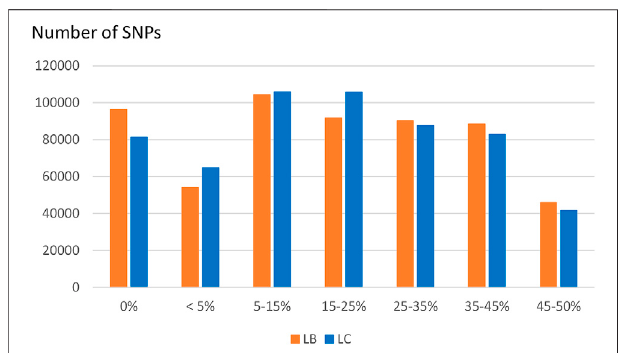
FIGURE 6 | Distribution of SNPs according to their MAF class in the LB and LC French commercial